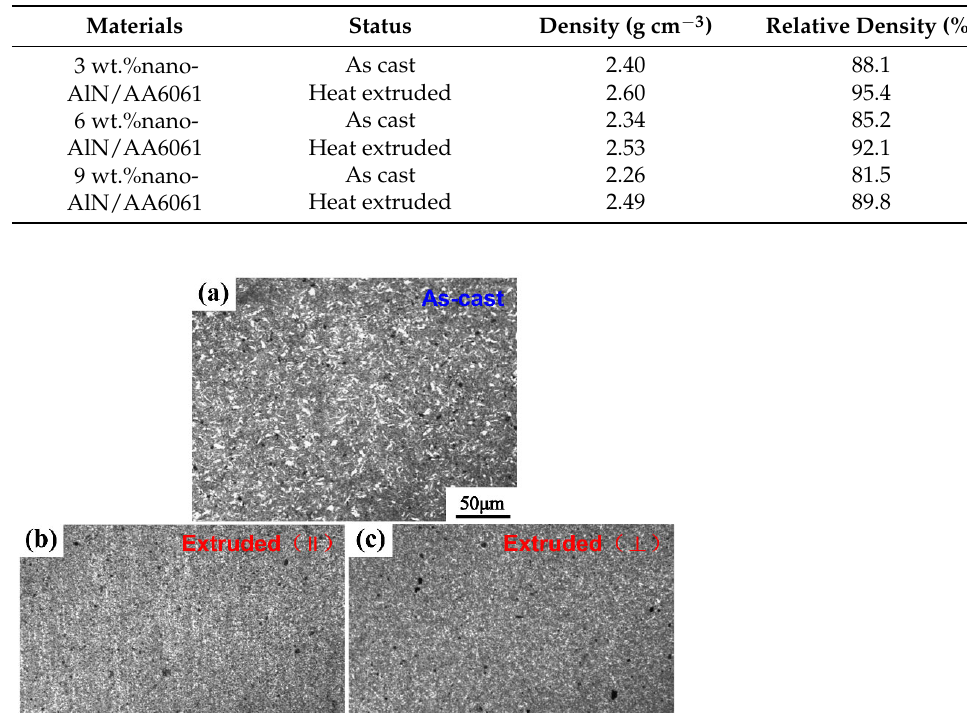
Table 2. Density and relative density of nano ‐ AlN composites of as ‐ cast and HE.